Question: Write a caption explaining this figure to a reader.
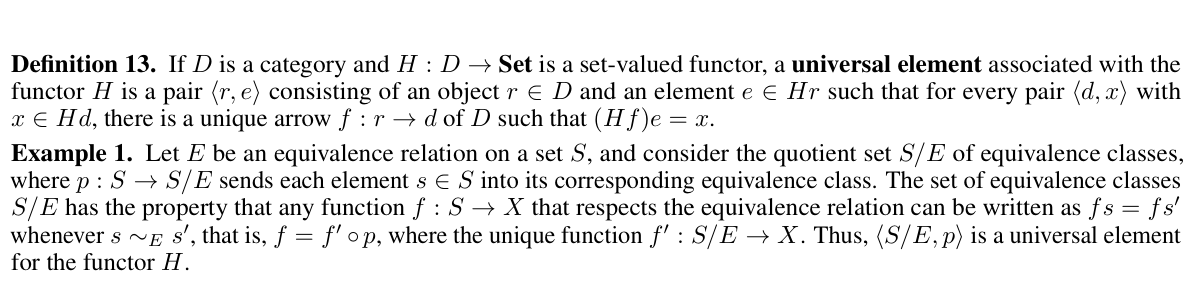
Answer: illustrates the concept of universal arrows through the connection between categories and graphs. For every (directed) graph G, there is a universal arrow from G to the “forgetful” functor U mapping the category Cat of all categories to Graph, the category of all (directed) graphs, where for any category C, its associated graph is defined by U(C). Intuitively, this forgetful functor “throws” away all categorical information, obliterating for example the distinction between the primitive morphisms f and g vs. their compositions g ◦f, both of which are simply viewed as edges in the graph U(C). To understand this functor, consider a directed graph U(C) defined from a category C, forgetting the rule for composition. That is, from the category C, which associates to each pair of composable arrows f and g, the composed arrow g ◦f, we derive the underlying graph U(C) simply by forgetting which edges correspond to elementary arrows, such as f or g, and which are composites. For examp